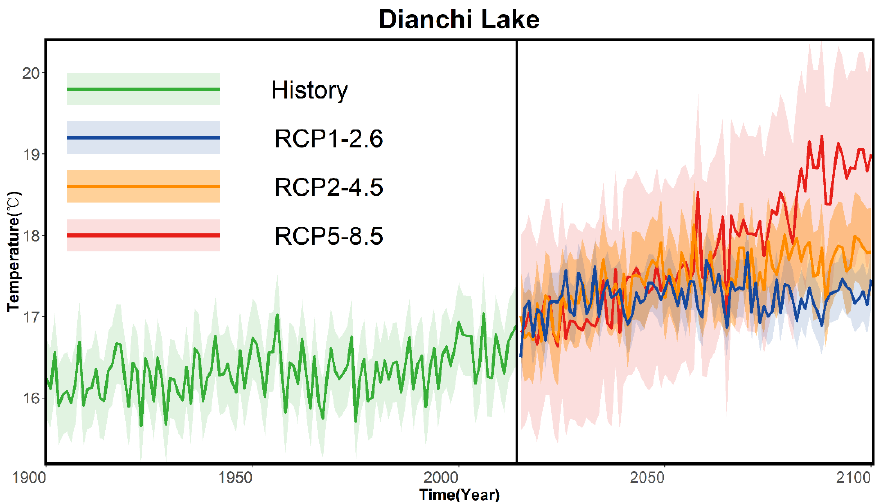
Figure 2. Trend diagrams for the annual average lake surface water temperature in Dianchi Lake under the three scenarios. The thick line represents the average annual water temperature, the legend shows the model information, and the shading represents the ±1.64 σ interval, where σ is the standard deviation of the annual average (close to the average). The research results show that the surface water temperature of Dianchi Lake did not change much in the historical period; the surface water temperature of Dianchi Lake shows different variation characteristics in different scenarios.